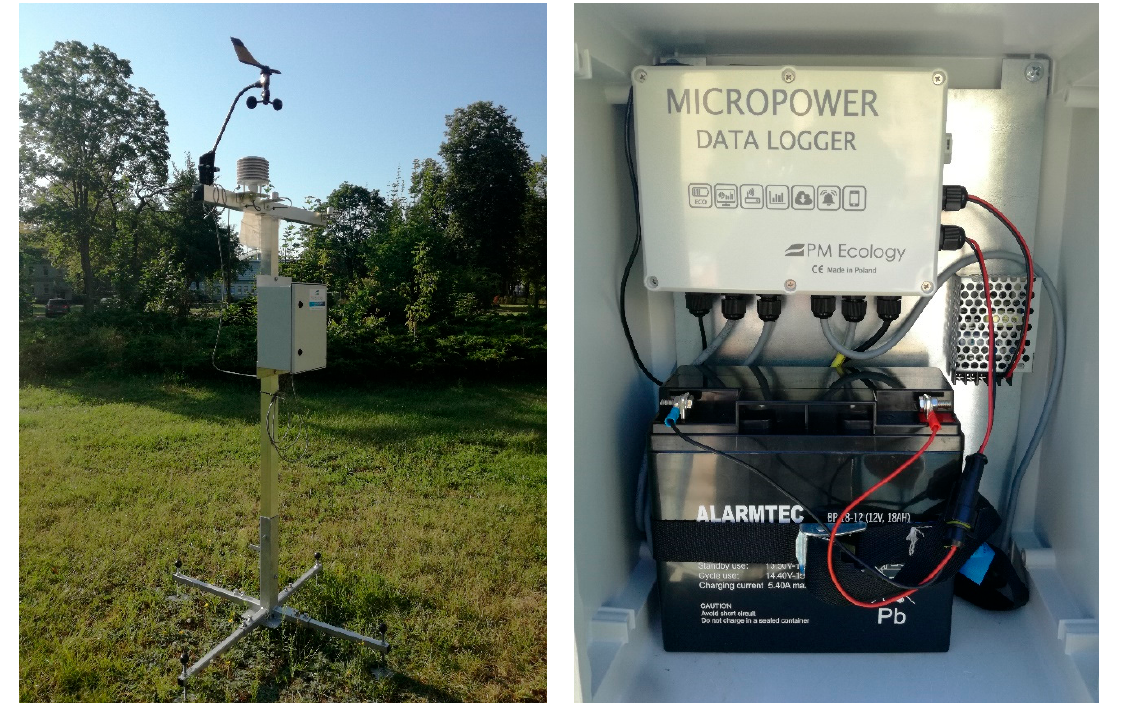
Figure 11. Meteorological station and its electronic module.